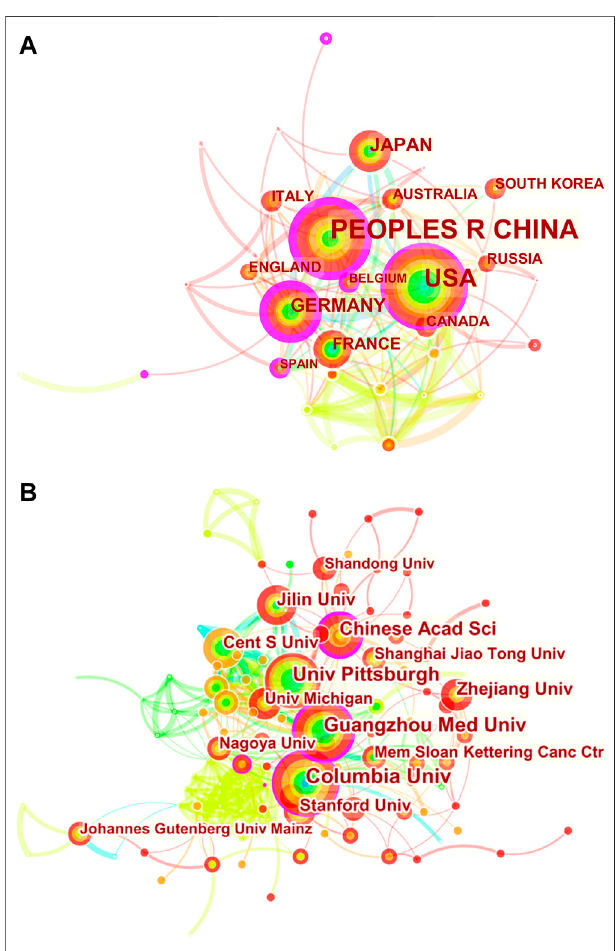
FIGURE2| CiteSpacenetworkvisualizationmapofcountry/regionsand institutions involved in ferroptosis in cancer research. (A) Collaboration analysis of countries/regions. (B) Collaboration analysis of institutions.